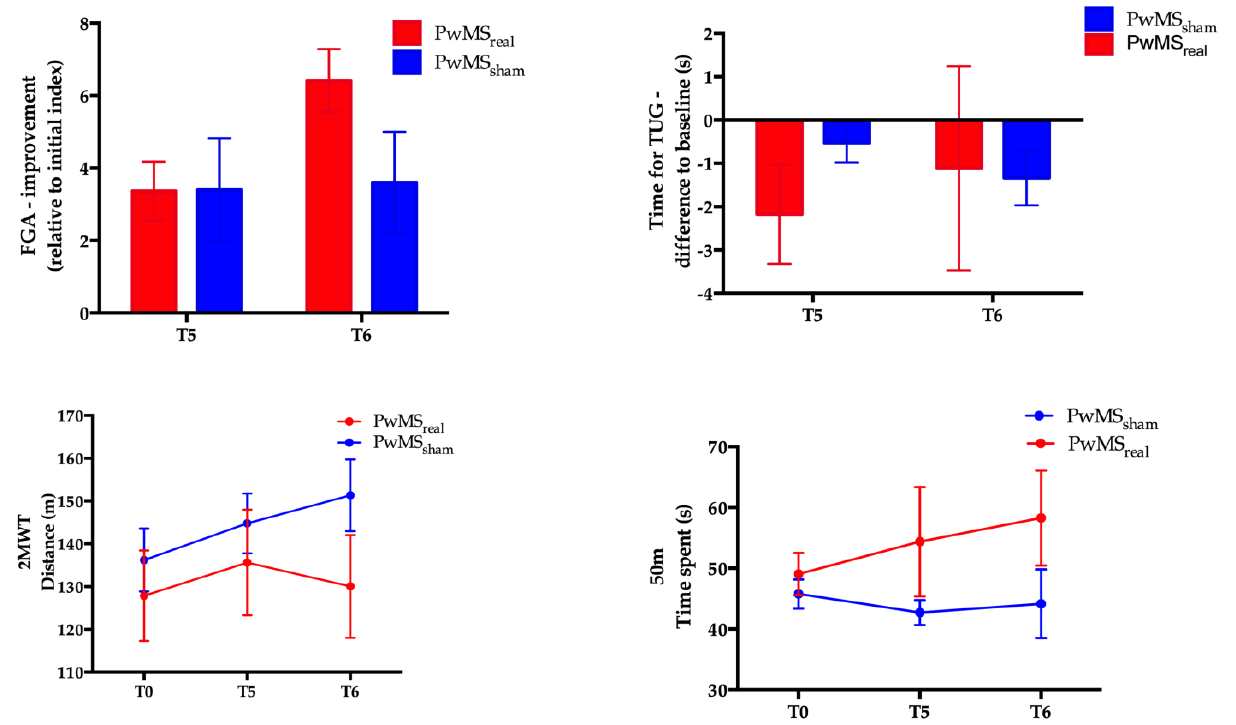
Figure 2. ( A ) Change in functional gait assessment (FGA) scores at T5 and T6 relative to baseline for PwMS real and PwMS sham . ( B ) Change in time for the timed-up and go (TUG) at T5 and T6 relative to baseline for PwMS real and PwMS sham . ( C ) Distance walked in 2 min at T0, T5, and T6 for PwMS real and PwMS sham . ( D ) Time taken to complete the 50 m overground walking test at T0, T5, and T6 for PwMS real and PwMS sham . Note: Error bars represent the standard error of the